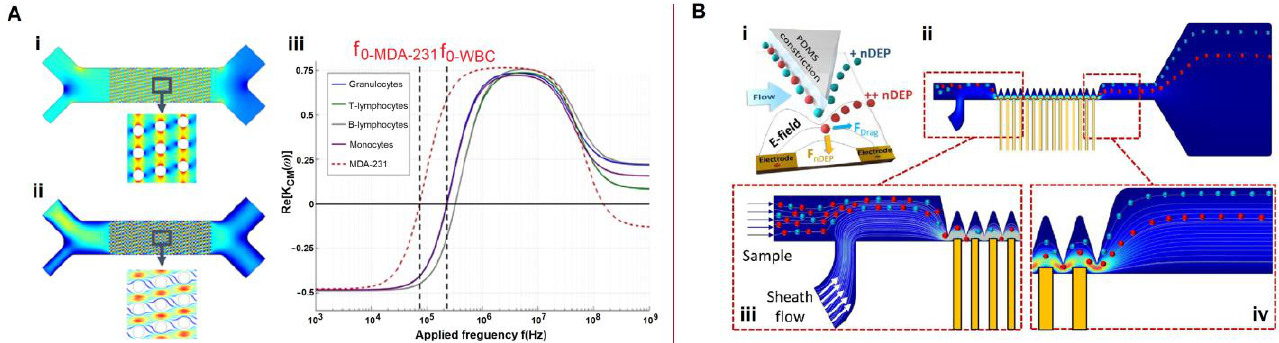
Figure 8. Microfluidic systems for measuring the dielectric properties of blood and blood cells. ( A ) Coupled DLD-DEP device: ( i ) Electric field norm ( V / m ). ( ii ) Velocity field ( m / s ). ( iii ) The real part of Clausius–Mossotti factor for granulocytes, T-lymphocytes, B-lymphocytes, monocytes, and MDA − 231. Reproduced with permission from [151]. Copyright 2019, WILEY-VCH Verlag GmbH & Co. KGaA, Weinheim. ( B ) The working principle of a dynamic dielectrophoresis (Dy-DEP) device: ( i ) Balancing nDEP and drag forces. ( ii ) Schematic of chip design. ( iii ) Focusing effect of the sheath flow. ( iv ) Cells with different DEP characteristics follow different streamlines. Reproduced with permission from [152]. Copyright 2020, Springer-Verlag GmbH Germany, part of Springer Nature.